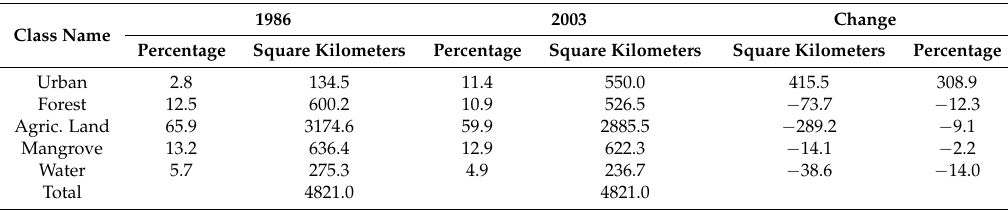
Table 2. Changes in urban area and other LULC categories between 1986–2003. Changes in this table indicate that there was a significant increase in urban area.